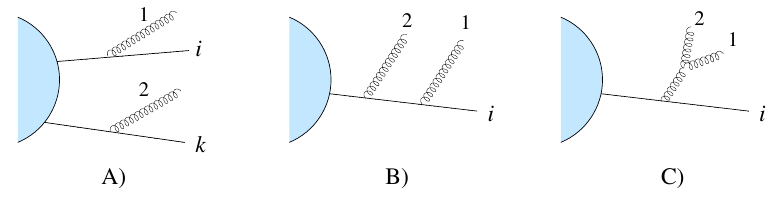
Figure 1 . Diagrams contributing to the two-gluon soft